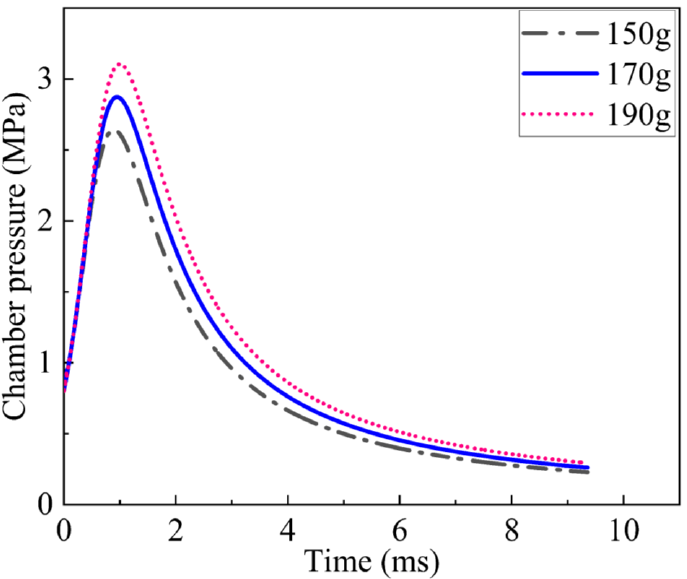
Figure 18. Chamber pressure with different towing block mass values.